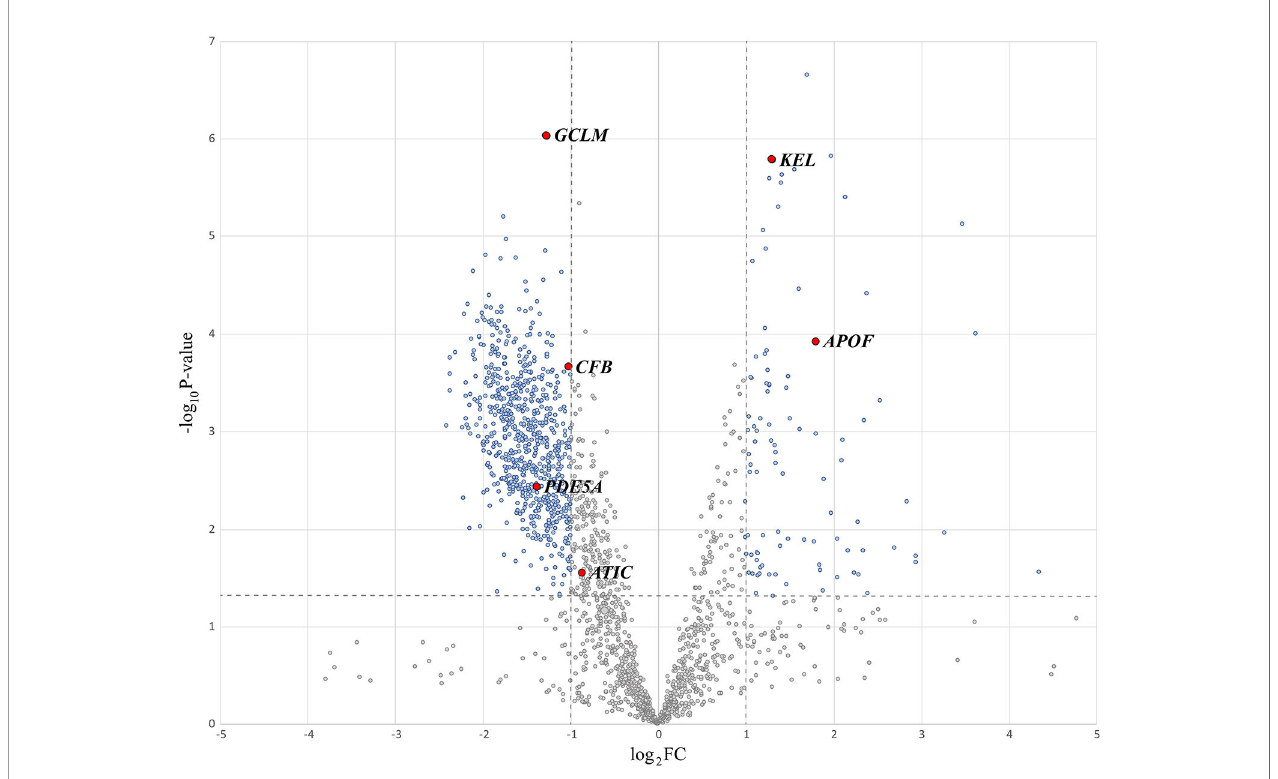
FIGURE 3 | Volcano plot highlighting signi fi cant